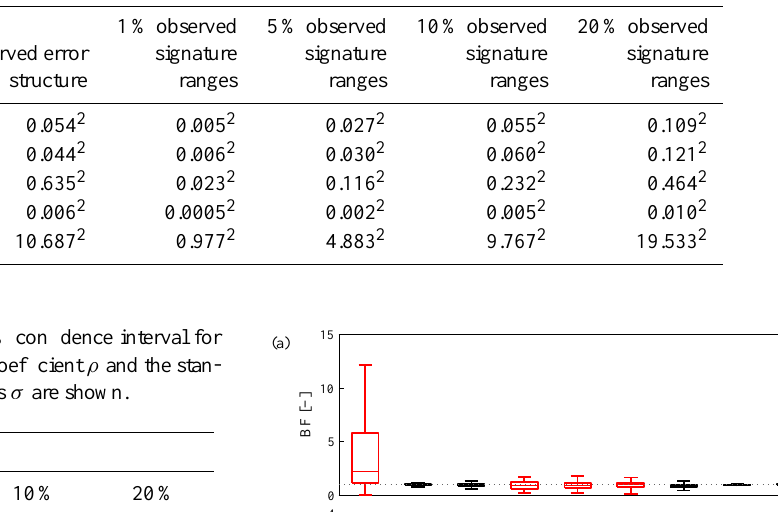
Table 2. Tested variance values for the data-based and imposed error structures.